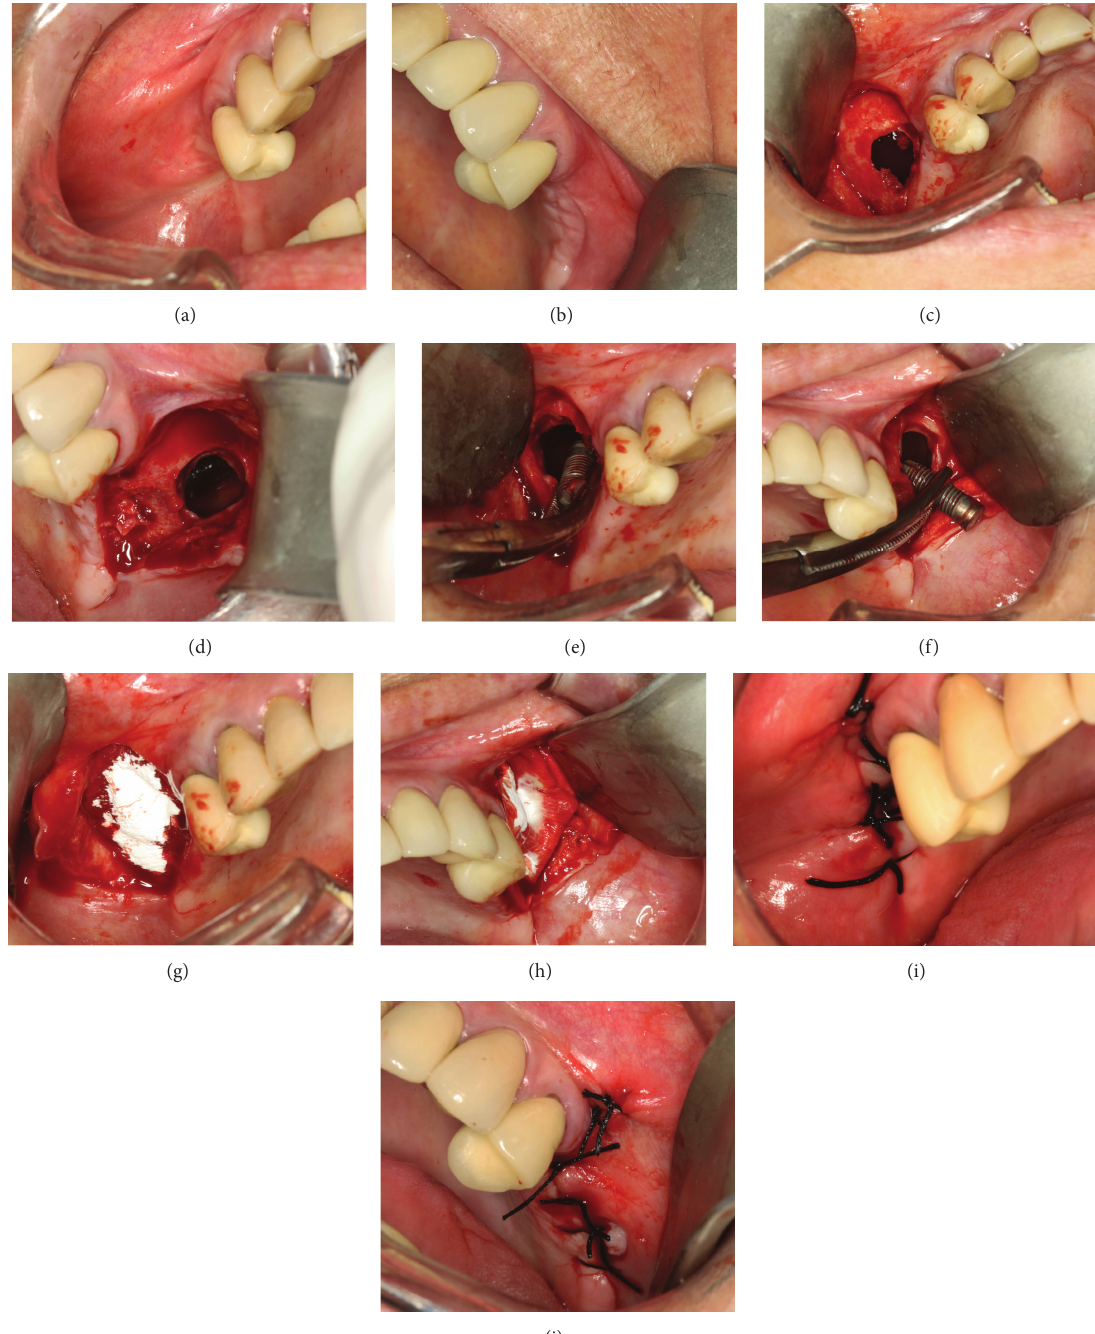
Figure 2: (a) Clinical photograph showing the clinical view of the right side. (b) Clinical photograph showing the clinical view of the left side. (c) Clinical photograph showing membrane perforation through the right bone window to gain full access into the sinus cavity. (d) Clinical photograph showing membrane perforation through the left bone window to gain full access into the sinus cavity. (e) Clinical photograph showing the implant removed with a Kelly clamp in the right sinus. (f) Clinical photograph showing the implant removed with a Kelly clamp in the left sinus. (g) Clinical photograph showing a porcine collagen membrane (Geistlich Bio-Gide, Switzerland) installed in the lateral bone window to protect the right sinus cavity. (h) Clinical photograph showing a porcine collagen membrane (Geistlich Bio-Gide, Switzerland) installed in the lateral bone window to protect the left sinus cavity. (i) Clinical photograph showing the surgical flap sutured (right side). (j) Clinical photograph showing the surgical flap sutured (left